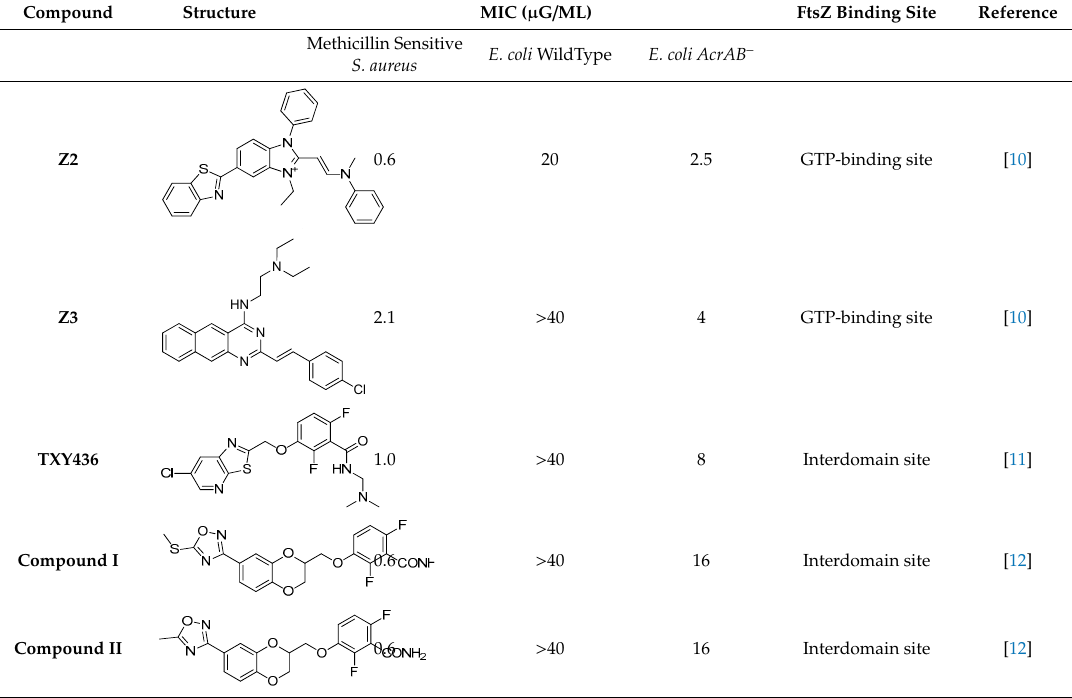
Table 1. Literature FtsZ inhibitors with promising activities on Gram-negative strains. Compound